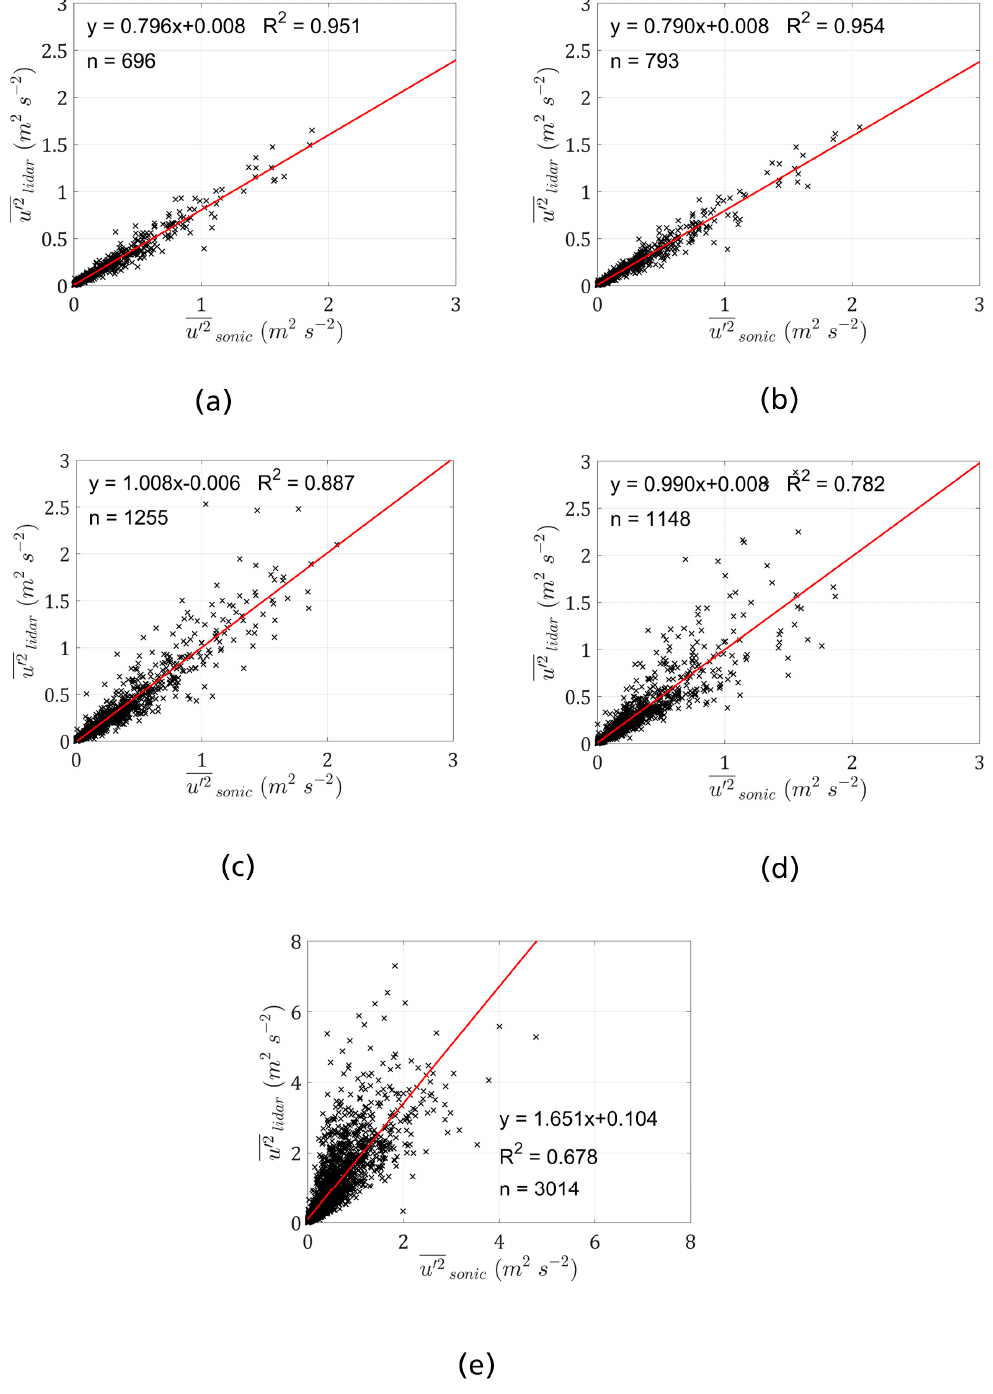
Figure 7. Scatter plots of u (cid:48) 2 from different lidar configurations against the reference sonic at 188 m; ( a ) SE, SW and EE; ( b ) SE and SW; ( c ) SE and EE; ( d ) SW and EE; ( e ) Windcube v2 next to the mast; ( a – d ) are measurements from WindScanners in ML mode; the Wincube is operated in DBS mode. For ML combinations with only two beams, w = 0 m · s − 1 is assumed in the wind-vector reconstruction; n indicates the number of value pairs displayed in the individual scatter plots.